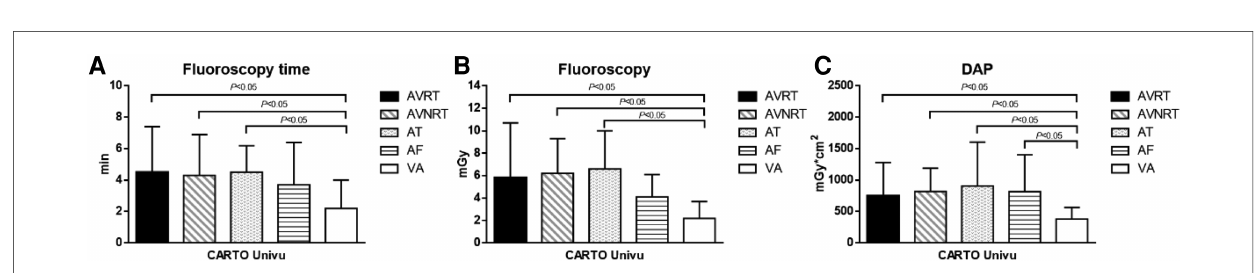
FIGURE 3 Comparison of fl uoroscopy for different types of tachyarrhythmias in the C3U group. ( A ) Shows the fl uoroscopy time; ( B ) Shows the fl uoroscopy dose; ( C ) Shows the dose area product